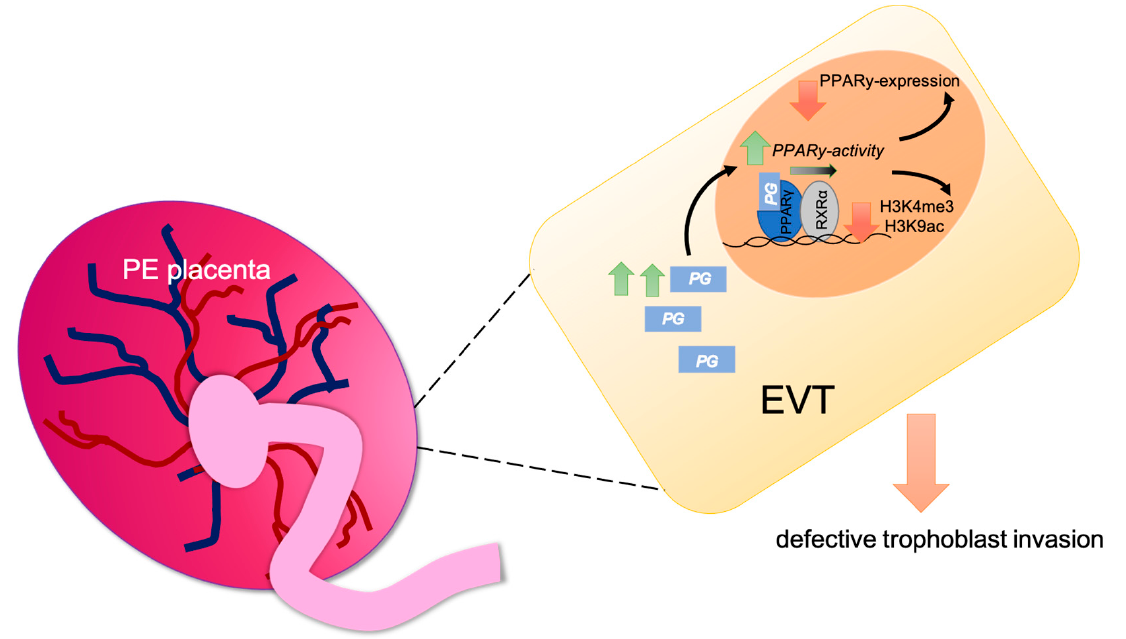
Figure 8. Graphical abstract of the hypothesis of PPAR γ regulating H3K4me3 and H3K9ac in EVT (PG (prostaglandin)).